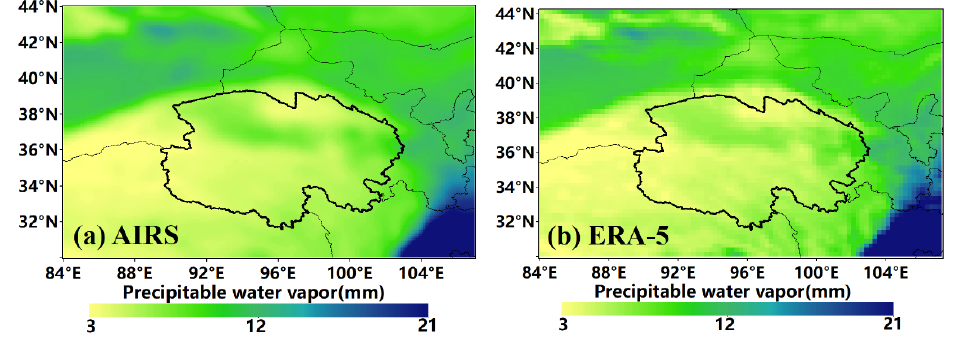
Figure 3. Multi-year mean of PWV in the study area. ( a )AIRS PWV, ( b )ERA-5 PWV.